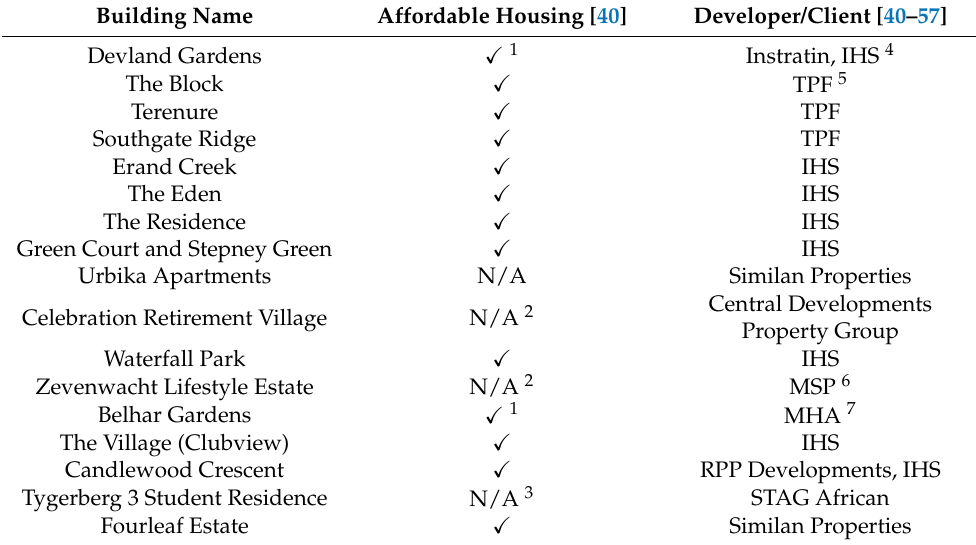
Table 9. Affordability in the 17 EDGE-certified